Question: In a single sentence, describe what this figure presents.
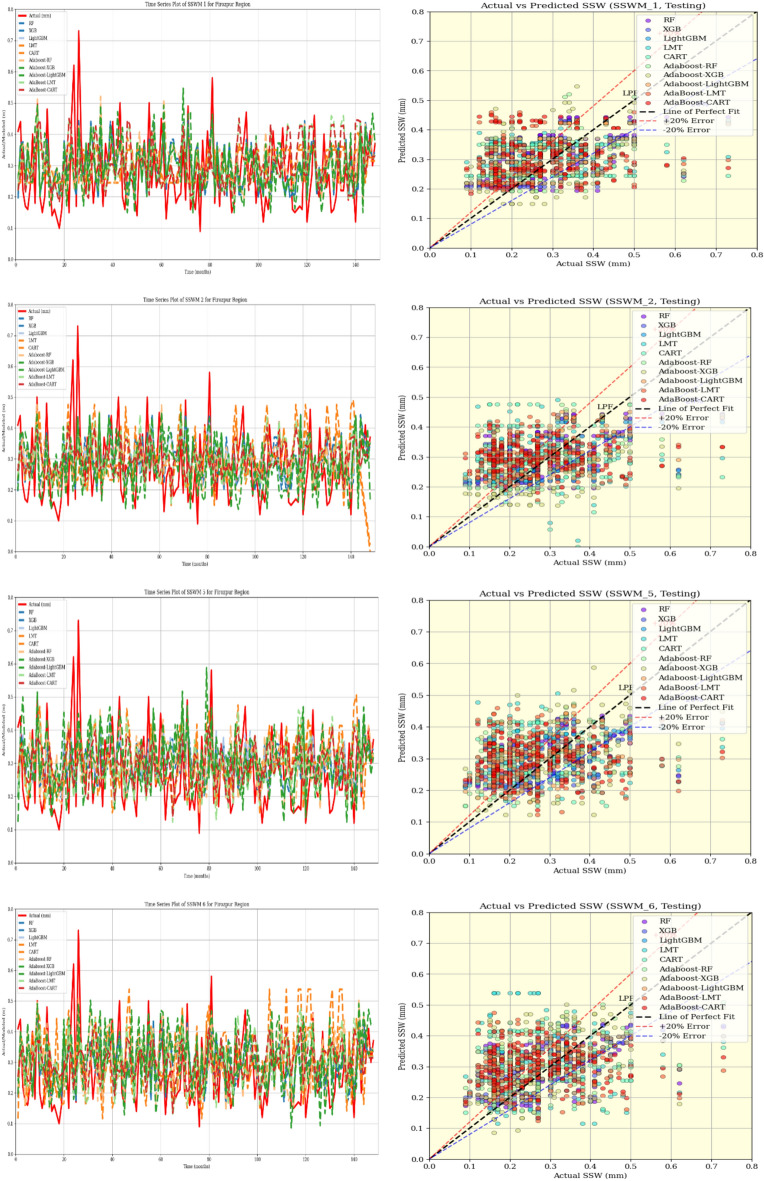
Answer: Time series plot of observed and predicted models and scatter plot between observed and predicted soil moisture wetness of the Firozpur during testing of the models.